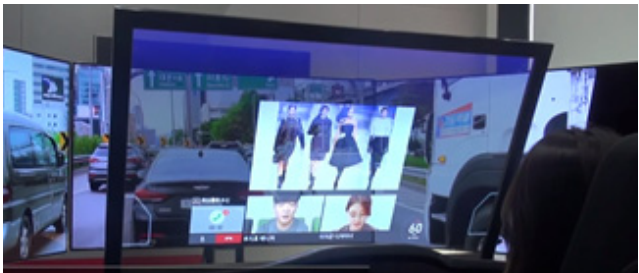
Figure 4. In-glass display concept.